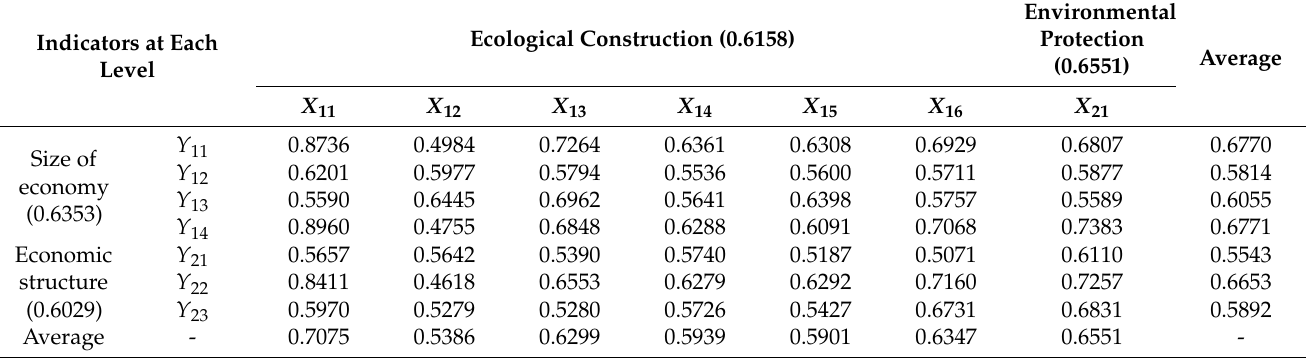
Table 3. Grey relational analysis correlation degree matrix between the environment and eco- nomic